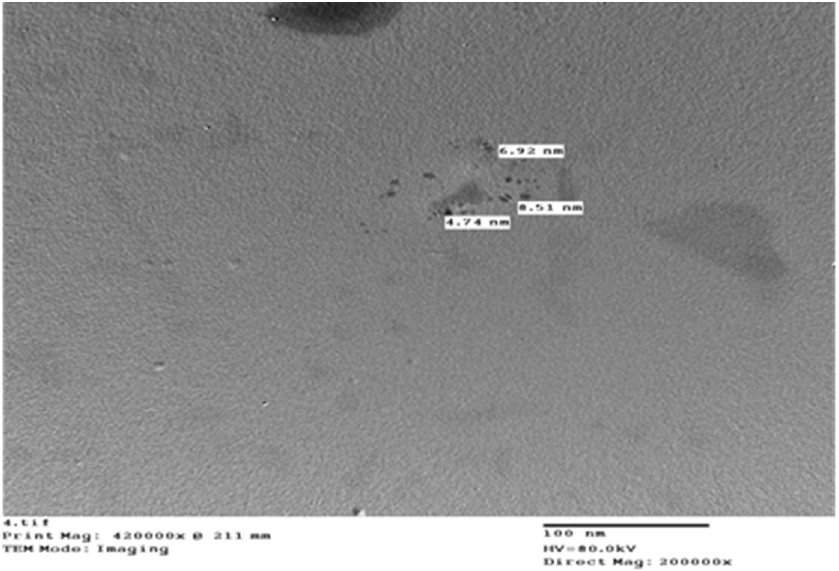
Figure 1. Scanning electron microscopy (SEM) for the prepared silicon nano ‐ particles. Silicon nano ‐ particle size from 4.75 to 6.92